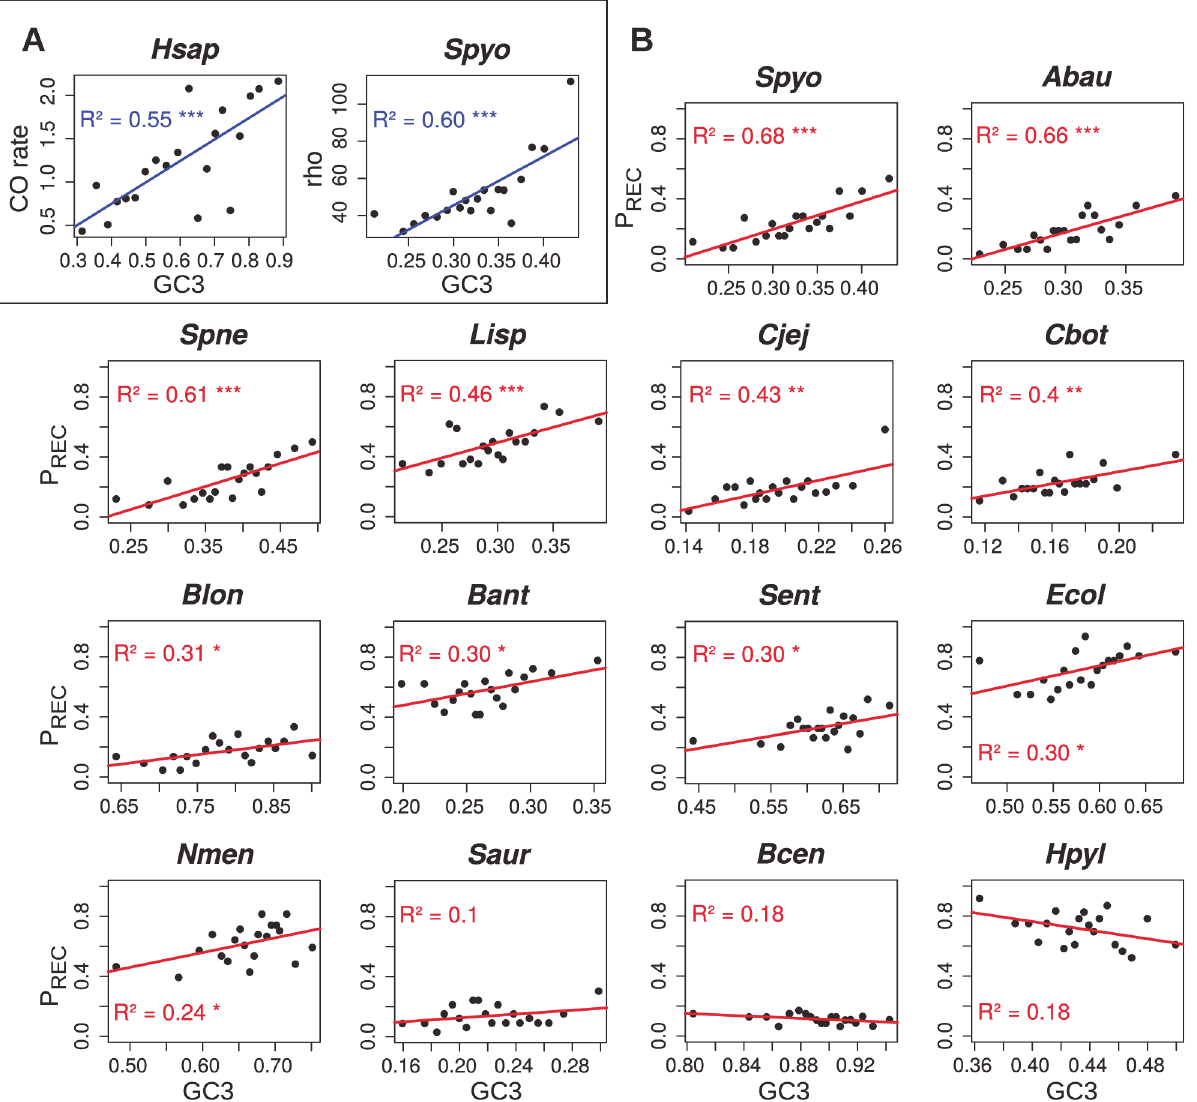
Figure 3. Correlations between GC3 and estimates of recombination rate. For each dataset, core genes are sorted by increasing GC3 and pooled into 20 classes of equal size. Correlations between the mean GC3 and mean recombination rate of each class are reported. (A) Correlation between GC3 and coalescent-based estimates of recombination rate for Homo sapiens ( Hsap ) and Stretococcus pyogenes ( Spyo ). For Hsap , recombination rate is expressed as cM ∙ Mb- 1; a subset of 600 genes out of the 16,346 human genes is shown as a representative of 1,000 random samples (mean R 2 is 55%, see Main Text). For Spyo , recombination rate is expressed as the value of rho parameter in ClonalOrigin [41] inferences, which is scaled by arbitrary coalescent time units; a subset of 437 genes out of 478 core genes was used, after removal of the 41 genes showing no convergence of the rho estimate (correlation on the full 478 core genes yields a R 2 of 31%, see S1 Text). (B) Correlation between GC3 and P REC , the proportion of genes detected as recombinant by PHI test [28] in the class, for all 14 bacterial datasets showing sufficient evidence of recombination (Table